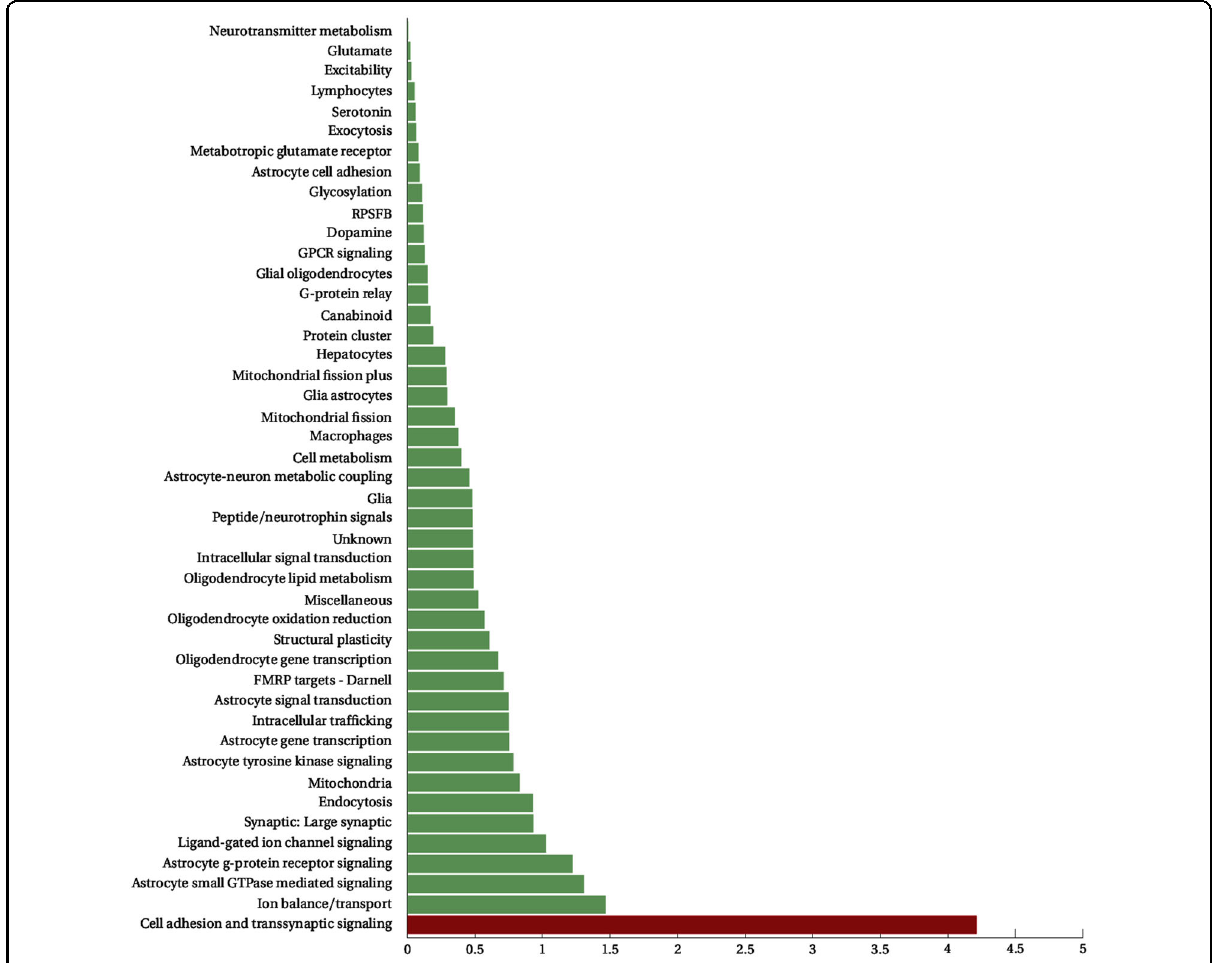
Fig. 1 Results of gene set analysis as implemented by MAGMA. The gene set that crossed the signi fi cance threshold is depicted in